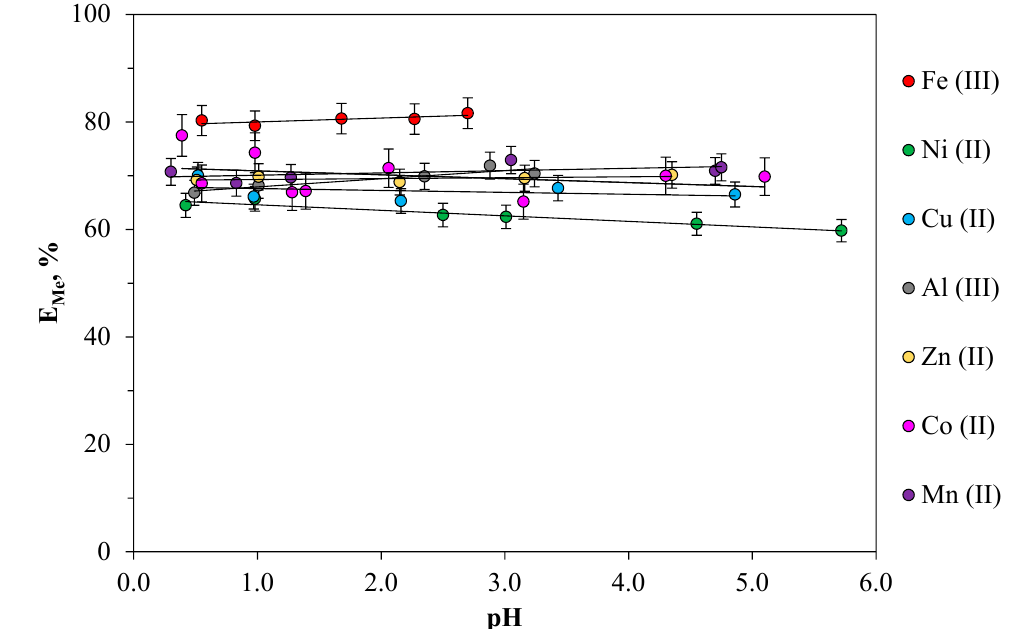
Figure 4. E ff ect of pH on the metal extraction in the PEO 1500 (16.3 wt%)-NaNO 3 (36.0 wt%)-H 2 O Figure 4. Effect of рН on the metal extraction in the PEO 1500 (16.3 wt%)-NaNO 3 (36.0 wt%)-H 2 O system: [Me] in = 0.01 mol·L − 1 , temperature: 298.15 K, and phase ratio: 1:1. system: [Me] in = 0.01 mol · L − 1 , temperature: 298.15 K, and phase ratio: